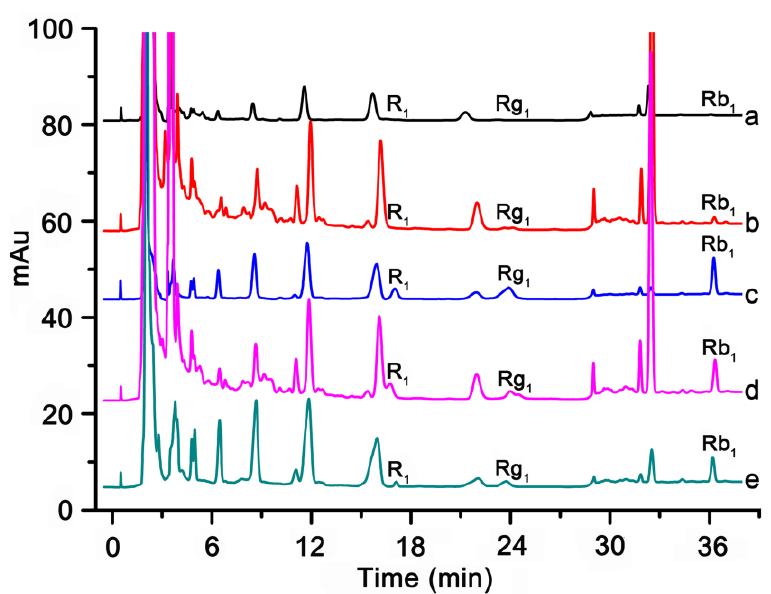
Figure 9. Chromatograms of Rb 1 , Rg 1 , R 1 in rat plasma samples (a) by direct injection without enrichment; (b) the washing solution protocol obtained from MISPE; (c) the elution solution protocol obtained from MISPE; (d) the washing solution protocol obtained from NISPE; (e) the elution solution protocol obtained from NISPE.